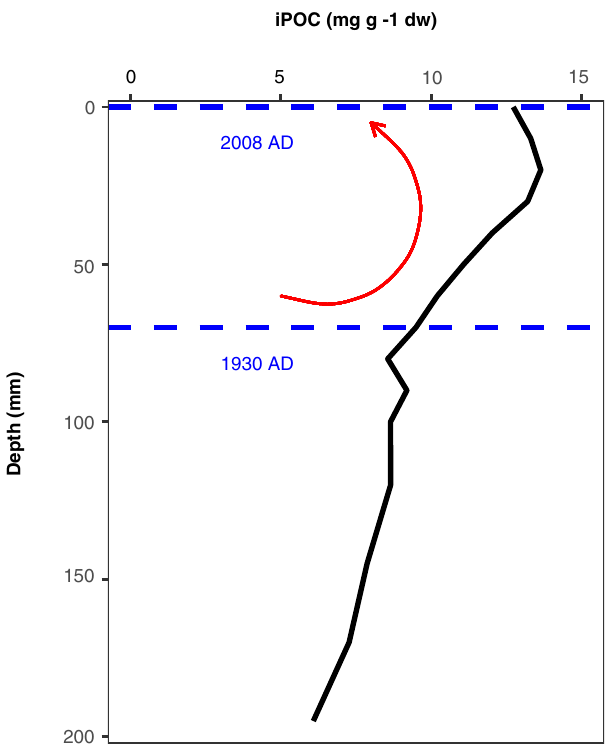
Fig. 5 | Maximum theoretical estimate of sea ice-derived carbon in marine sediments in the shallow Southeast Beaufort Sea shelf region. Black line shows estimatedsea-iceorganic carbon (iPOC) concentration. Horizontalblue linesshow Pb 210 dates corresponding to sampling (upper) and 70mm (lower). Red arrow indicates region of bioturbation potential and accessible